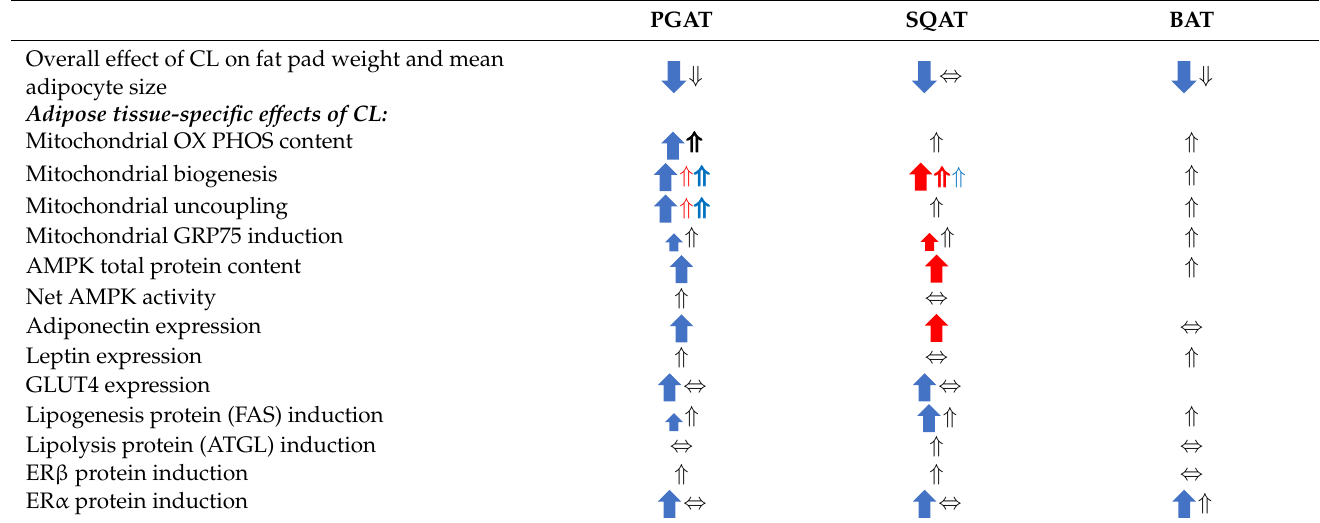
⇑ Black arrows indicate sex-independent effects; colored arrows (female, male) represent sex-specific effects (i.e., sex interactions); bold  arrows represent greater magnitude of effect; smaller arrows represent modest/trending effect; solid arrows represent sex differences at  Black arrows indicate sex-independent effects; colored arrows (female, male) represent sex-specific effects (i.e., sex inter- Black arrows indicate sex-independent effects; colored arrows (female, male) represent sex-specific effects (i.e., sex inter- Black arrows indicate sex-independent effects; colored arrows (female, male) represent sex-specific effects (i.e., sex inter-   Black arrows indicate sex-independent effects; colored arrows (female, male) represent sex-specific effects (i.e., sex inter- baseline. * Regarding systemic metabolism, in both males and females, CL improved body composition by reducing fat mass, preserving Black arrows indicate sex-independent effects; colored arrows (female, male) represent sex-specific effects (i.e., sex inter- Black arrows indicate sex-independent effects; colored arrows (female, male) represent sex-specific effects (i.e., sex inter- Black arrows indicate sex-independent effects; colored arrows (female, male) represent sex-specific effects (i.e., sex inter- actions); bold arrows represent greater magnitude of effect; smaller arrows represent modest/trending effect; solid arrows actions); bold arrows represent greater magnitude of effect; smaller arrows represent modest/trending effect; solid arrows actions); bold arrows represent greater magnitude of effect; smaller arrows represent modest/trending effect; solid arrows lean mass, and reducing visceral adiposity and mean adipocyte size. In both sexes, those improvements were attributed to increased resting    actions); bold arrows represent greater magnitude of effect; smaller arrows represent modest/trending effect; solid arrows Black arrows indicate sex-independent effects; colored arrows (female, male) represent sex-specific effects (i.e., sex inter- actions); bold arrows represent greater magnitude of effect; smaller arrows represent modest/trending effect; solid arrows actions); bold arrows represent greater magnitude of effect; smaller arrows represent modest/trending effect; solid arrows actions); bold arrows represent greater magnitude of effect; smaller arrows represent modest/trending effect; solid arrows represent sex differences at baseline. * Regarding systemic metabolism, in both males and females, CL improved body represent sex differences at baseline. * Regarding systemic metabolism, in both males and females, CL improved body energy expenditure despite no changes in energy intake or physical activity. CL also improved glucose tolerance in both  represent sex differences at baseline. * Regarding systemic metabolism, in both males and females, CL improved body represent sex differences at baseline. * Regarding systemic metabolism, in both males and females, CL improved body actions); bold arrows represent greater magnitude of effect; smaller arrows represent modest/trending effect; solid arrows Black arrows indicate sex-independent effects; colored arrows (female, male) represent sex-specific effects (i.e., sex inter- represent sex differences at baseline. * Regarding systemic metabolism, in both males and females, CL improved body represent sex differences at baseline. * Regarding systemic metabolism, in both males and females, CL improved body represent sex differences at baseline. * Regarding systemic metabolism, in both males and females, CL improved body composition by reducing fat mass, preserving lean mass, and reducing visceral adiposity and mean adipocyte size. In both composition by reducing fat mass, preserving lean mass, and reducing visceral adiposity and mean adipocyte size. In both composition by reducing fat mass, preserving lean mass, and reducing visceral adiposity and mean adipocyte size. In both Black arrows indicate sex-independent effects; colored arrows (female, male) represent sex-specific effects (i.e., sex inter- composition by reducing fat mass, preserving lean mass, and reducing visceral adiposity and mean adipocyte size. In both   represent sex differences at baseline. * Regarding systemic metabolism, in both males and females, CL improved body actions); bold arrows represent greater magnitude of effect; smaller arrows represent modest/trending effect; solid arrows composition by reducing fat mass, preserving lean mass, and reducing visceral adiposity and mean adipocyte size. In both composition by reducing fat mass, preserving lean mass, and reducing visceral adiposity and mean adipocyte size. In both composition by reducing fat mass, preserving lean mass, and reducing visceral adiposity and mean adipocyte size. In both sexes, those improvements were attributed to increased resting energy expenditure despite no changes in energy intake sexes, those improvements were attributed to increased resting energy expenditure despite no changes in energy intake sexes, those improvements were attributed to increased resting energy expenditure despite no changes in energy intake  actions); bold arrows represent greater magnitude of effect; smaller arrows represent modest/trending effect; solid arrows sexes, those improvements were attributed to increased resting energy expenditure despite no changes in energy intake composition by reducing fat mass, preserving lean mass, and reducing visceral adiposity and mean adipocyte size. In both represent sex differences at baseline. * Regarding systemic metabolism, in both males and females, CL improved body Black arrows indicate sex-independent effects; colored arrows (female, male) represent sex-specific effects (i.e., sex inter- sexes, those improvements were attributed to increased resting energy expenditure despite no changes in energy intake sexes, those improvements were attributed to increased resting energy expenditure despite no changes in energy intake sexes, those improvements were attributed to increased resting energy expenditure despite no changes in energy intake or physical activity. CL also improved glucose tolerance in both sexes. or physical activity. CL also improved glucose tolerance in both sexes. or physical activity. CL also improved glucose tolerance in both sexes. represent sex differences at baseline. * Regarding systemic metabolism, in both males and females, CL improved body or physical activity. CL also improved glucose tolerance in both sexes. Black arrows indicate sex-independent effects; colored arrows (female, male) represent sex-specific effects (i.e., sex inter- sexes, those improvements were attributed to increased resting energy expenditure despite no changes in energy intake   composition by reducing fat mass, preserving lean mass, and reducing visceral adiposity and mean adipocyte size. In both actions); bold arrows represent greater magnitude of effect; smaller arrows represent modest/trending effect; solid arrows or physical activity. CL also improved glucose tolerance in both sexes. or physical activity. CL also improved glucose tolerance in both sexes. or physical activity. CL also improved glucose tolerance in both sexes. Black arrows indicate sex-independent effects; colored arrows (female, male) represent sex-specific effects (i.e., sex inter- composition by reducing fat mass, preserving lean mass, and reducing visceral adiposity and mean adipocyte size. In both  actions); bold arrows represent greater magnitude of effect; smaller arrows represent modest/trending effect; solid arrows or physical activity. CL also improved glucose tolerance in both sexes. sexes, those improvements were attributed to increased resting energy expenditure despite no changes in energy intake represent sex differences at baseline. * Regarding systemic metabolism, in both males and females, CL improved body Black arrows indicate sex-independent effects; colored arrows (female, male) represent sex-specific effects (i.e., sex inter- actions); bold arrows represent greater magnitude of effect; smaller arrows represent modest/trending effect; solid arrows sexes, those improvements were attributed to increased resting energy expenditure despite no changes in energy intake represent sex differences at baseline. * Regarding systemic metabolism, in both males and females, CL improved body    or physical activity. CL also improved glucose tolerance in both sexes. composition by reducing fat mass, preserving lean mass, and reducing visceral adiposity and mean adipocyte size. In both actions); bold arrows represent greater magnitude of effect; smaller arrows represent modest/trending effect; solid arrows represent sex differences at baseline. * Regarding systemic metabolism, in both males and females, CL improved body or physical activity. CL also improved glucose tolerance in both sexes. composition by reducing fat mass, preserving lean mass, and reducing visceral adiposity and mean adipocyte size. In both sexes, those improvements were attributed to increased resting energy expenditure despite no changes in energy intake represent sex differences at baseline. * Regarding systemic metabolism, in both males and females, CL improved body Black arrows indicate sex-independent effects; colored arrows (female, male) represent sex-specific effects (i.e., sex inter- Black arrows indicate sex-independent effects; colored arrows (female, male) represent sex-specific effects (i.e., sex inter- composition by reducing fat mass, preserving lean mass, and reducing visceral adiposity and mean adipocyte size. In both sexes, those improvements were attributed to increased resting energy expenditure despite no changes in energy intake or physical activity. CL also improved glucose tolerance in both sexes. composition by reducing fat mass, preserving lean mass, and reducing visceral adiposity and mean adipocyte size. In both actions); bold arrows represent greater magnitude of effect; smaller arrows represent modest/trending effect; solid arrows actions); bold arrows represent greater magnitude of effect; smaller arrows represent modest/trending effect; solid arrows Black arrows indicate sex-independent effects; colored arrows (female, male) represent sex-specific effects (i.e., sex inter- sexes, those improvements were attributed to increased resting energy expenditure despite no changes in energy intake or physical activity. CL also improved glucose tolerance in both sexes. sexes, those improvements were attributed to increased resting energy expenditure despite no changes in energy intake represent sex differences at baseline. * Regarding systemic metabolism, in both males and females, CL improved body represent sex differences at baseline. * Regarding systemic metabolism, in both males and females, CL improved body actions); bold arrows represent greater magnitude of effect; smaller arrows represent modest/trending effect; solid arrows or physical activity. CL also improved glucose tolerance in both sexes. or physical activity. CL also improved glucose tolerance in both sexes. composition by reducing fat mass, preserving lean mass, and reducing visceral adiposity and mean adipocyte size. In both composition by reducing fat mass, preserving lean mass, and reducing visceral adiposity and mean adipocyte size. In both represent sex differences at baseline. * Regarding systemic metabolism, in both males and females, CL improved body sexes, those improvements were attributed to increased resting energy expenditure despite no changes in energy intake sexes, those improvements were attributed to increased resting energy expenditure despite no changes in energy intake Black arrows indicate sex-independent effects; colored arrows (female, male) represent sex-specific effects (i.e., sex inter- Black arrows indicate sex-independent effects; colored arrows (female, male) represent sex-specific effects (i.e., sex inter- Black arrows indicate sex-independent effects; colored arrows (female, male) represent sex-specific effects (i.e., sex inter- composition by reducing fat mass, preserving lean mass, and reducing visceral adiposity and mean adipocyte size. In both or physical activity. CL also improved glucose tolerance in both sexes. or physical activity. CL also improved glucose tolerance in both sexes. actions); bold arrows represent greater magnitude of effect; smaller arrows represent modest/trending effect; solid arrows actions); bold arrows represent greater magnitude of effect; smaller arrows represent modest/trending effect; solid arrows actions); bold arrows represent greater magnitude of effect; smaller arrows represent modest/trending effect; solid arrows sexes, those improvements were attributed to increased resting energy expenditure despite no changes in energy intake represent sex differences at baseline. * Regarding systemic metabolism, in both males and females, CL improved body represent sex differences at baseline. * Regarding systemic metabolism, in both males and females, CL improved body represent sex differences at baseline. * Regarding systemic metabolism, in both males and females, CL improved body or physical activity. CL also improved glucose tolerance in both sexes. composition by reducing fat mass, preserving lean mass, and reducing visceral adiposity and mean adipocyte size. In both composition by reducing fat mass, preserving lean mass, and reducing visceral adiposity and mean adipocyte size. In both composition by reducing fat mass, preserving lean mass, and reducing visceral adiposity and mean adipocyte size. In both sexes, those improvements were attributed to increased resting energy expenditure despite no changes in energy intake sexes, those improvements were attributed to increased resting energy expenditure despite no changes in energy intake sexes, those improvements were attributed to increased resting energy expenditure despite no changes in energy intake or physical activity. CL also improved glucose tolerance in both sexes. or physical activity. CL also improved glucose tolerance in both sexes. or physical activity. CL also improved glucose tolerance in both sexes.